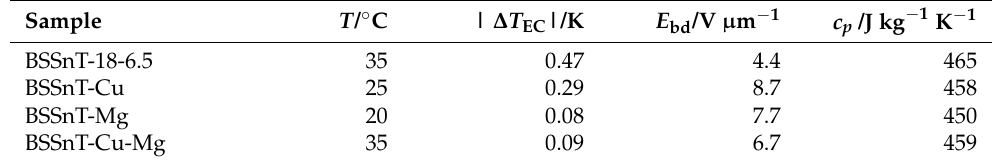
Figure 9. Electrocaloric temperature change ( | ∆ T EC | ) depending on temperature ( T ) for BSSnT-18-6.5 with different additives measured at ∆ E = 2 V µ m − 1 . Table 4. Compilation of maximum electrocaloric temperature change ( | ∆ T EC | ) measured at an electric and specific heat capacity ( c p ) at zero electric